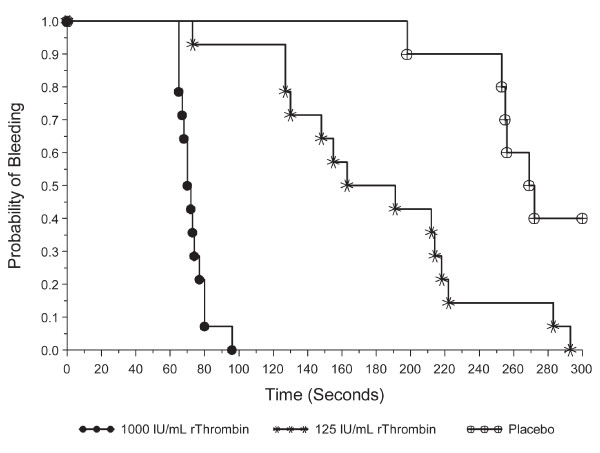
Kaplan-Meier estimates for the probability of bleeding after treatment with different concentrations of rThrombin or placebo. TTH was measured in the rabbit AV shunt model of anastomotic bleeding after treatment with heparin + clopidogrel. PTFE graft segments were punctured, and AGS containing a standardized volume of 1000 IU/mL or 125 IU/mL rThrombin or placebo was applied to the bleeding surface. The TTH observation period extended from 60 seconds to 300 seconds. 1000 IU/mL rThrombin: N = 14 grafts. 125 IU/mL rThrombin: N = 14 grafts. Placebo: N = 10 grafts.